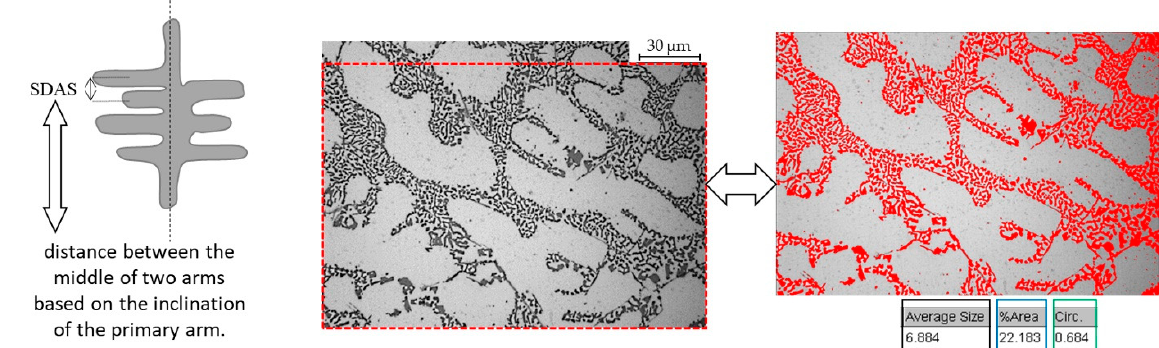
Figure 1. Secondary dendrite arm spacing (SDAS) measurement and image analysis. Left image: SDAS measurement procedure as in [39]. Center and right images: image analysis details on the eutectic phase (average size, circularity, % area occupied). Optical images at 50X magnification.